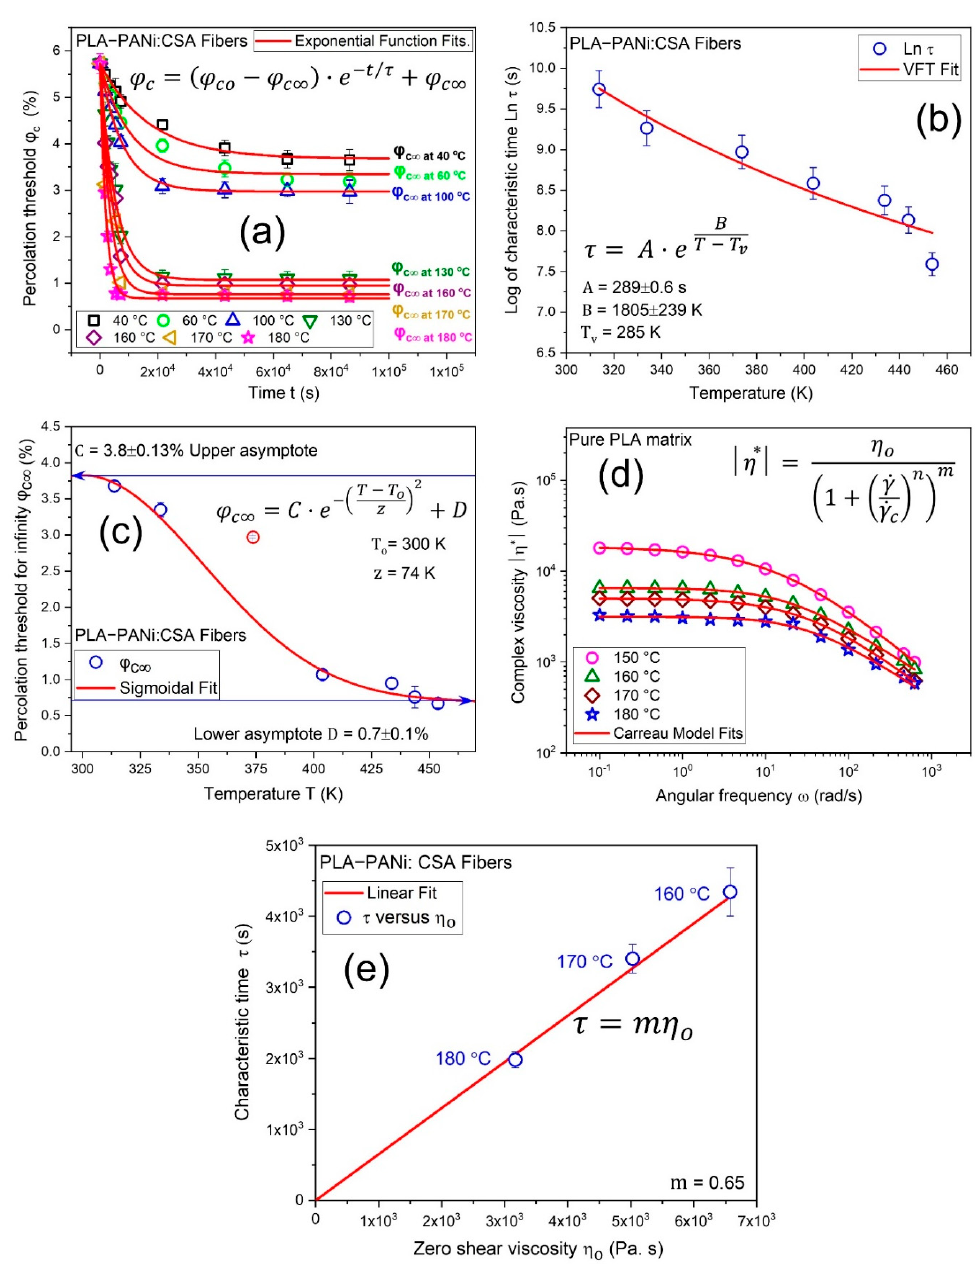
Figure 4. ( a ) shows an exponential function (Equation (5)) fit to determine infinite percolation threshold φ c ∞ and characteristic time τ . ( b ) shows a semi-logarithmic representation of the characteristic time τ as a function of temperature T , where the red solid line is a fit of the Vogel–Fulcher–Tammann (VFT) equation (Equation (6)). ( c ) shows a fit of sigmoidal function (Equation (7)) to describe φ c ∞ as a limit of temperature T . ( d ) shows the viscosity curve of PLA in relation to shear rate at 150, 160, 180, and 180 °C and a Carreau model (Equation (8)) is fitted to determine the zero-shear viscosity η o . ( e ) shows the linear dependence between characteristic time τ and zero-shear viscosity η o, and the linear fit is with intercept c = 0.